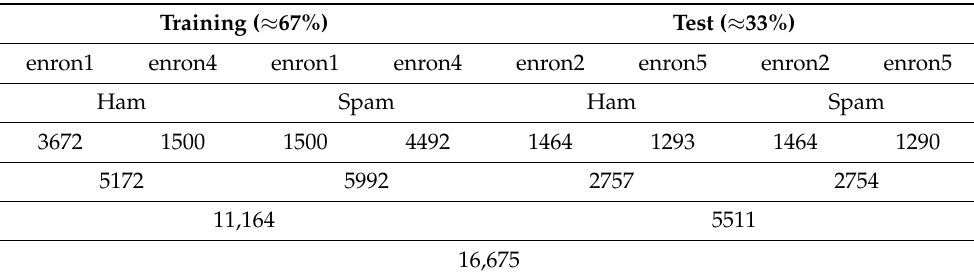
Table 6. Dataset 3 structure.